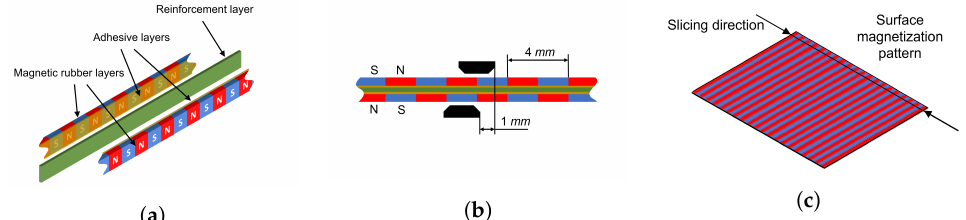
Figure 6. Depiction of the magnetic scale and relative sensor alignments: ( a ) scale composed of two magnetic rubber layers, with pre-applied adhesive and a reinforcement layer for added longitudinal stiffness; ( b ) top view showing the sensor offset distance and the spacial period of the magnetic poles (only the outermost magnetic layer is depicted for clarity); ( c ) magnetic rubber sheet pattern and slicing direction. The blue and red colours represent the magnetic South and North poles